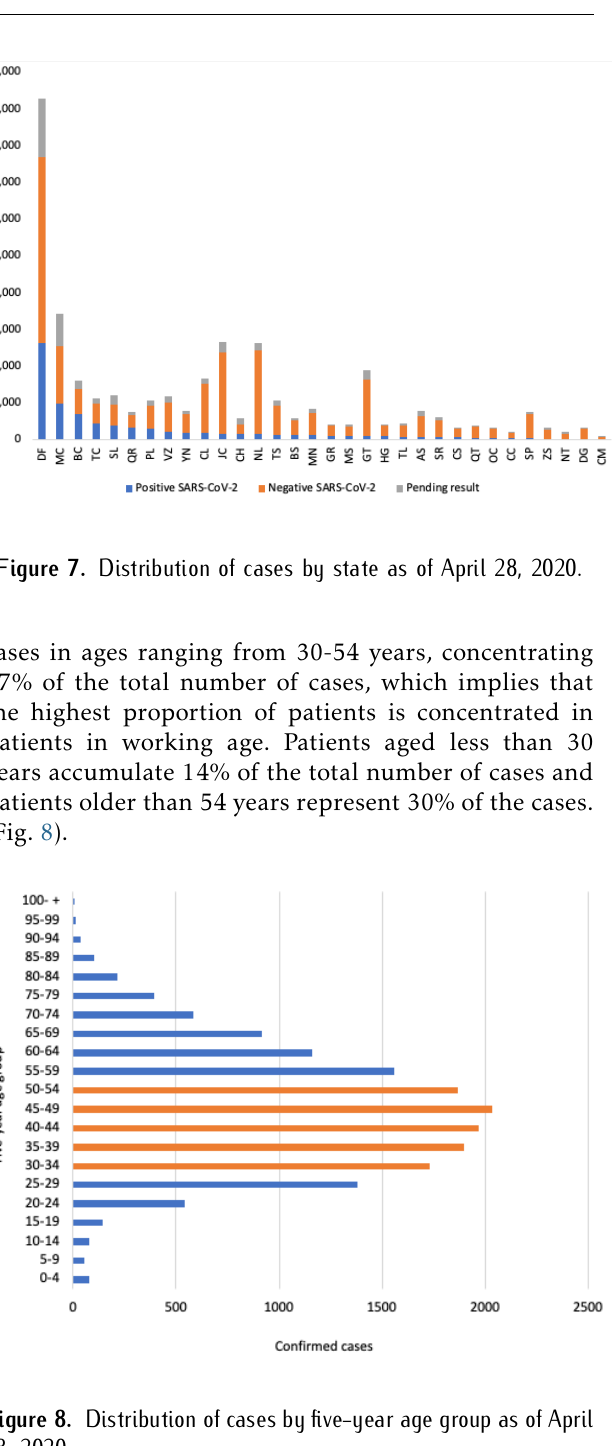
Figure 8. Distribution of cases by five-year age group as of